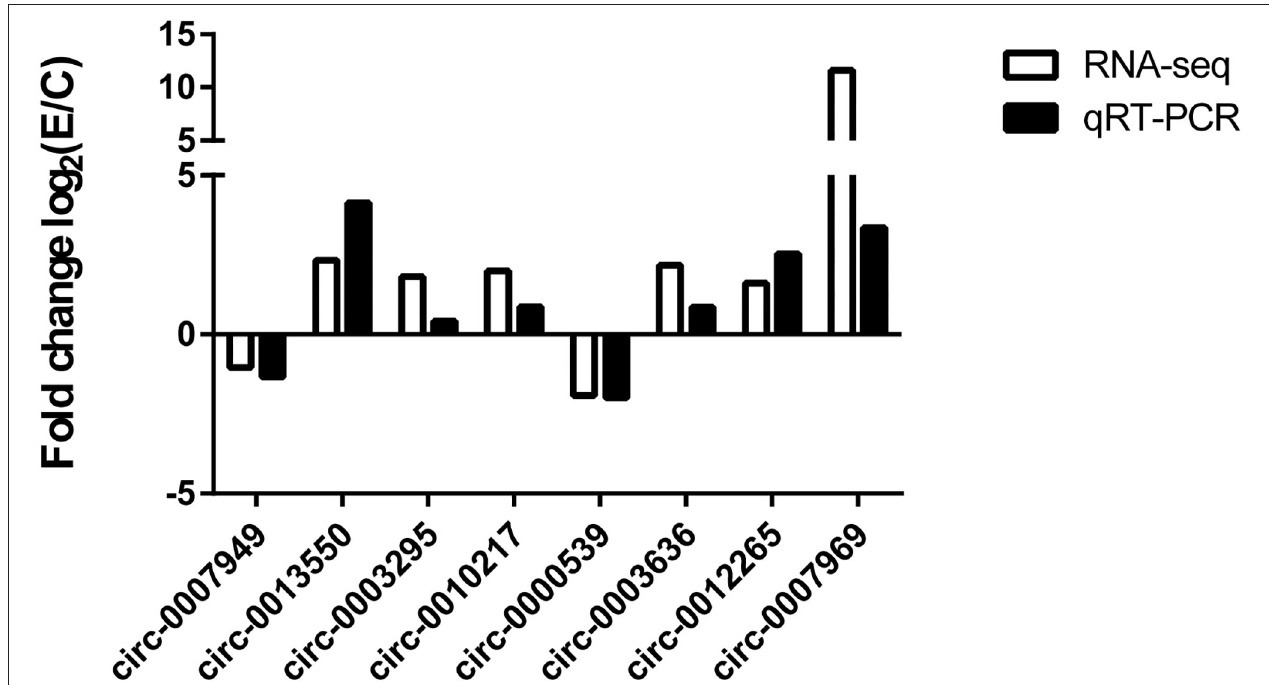
FIGURE 6 | Comparison of results of circRNA sequencing and qRT-PCR. The number of biological replicates for each experiment was 3, and the relative expression levels were normalized to the expression level of GAPDH. Data are presented as means with SD. P -values were analyzed by Student’s t